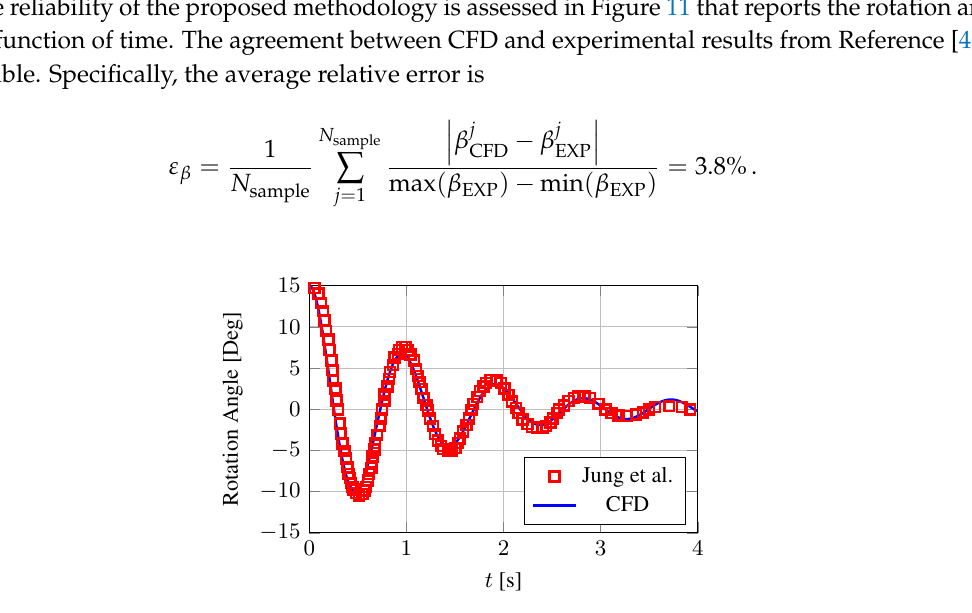
Figure 11. Rotation of the specimen about its center of mass. Comparison between CFD and experiments from Reference [40].